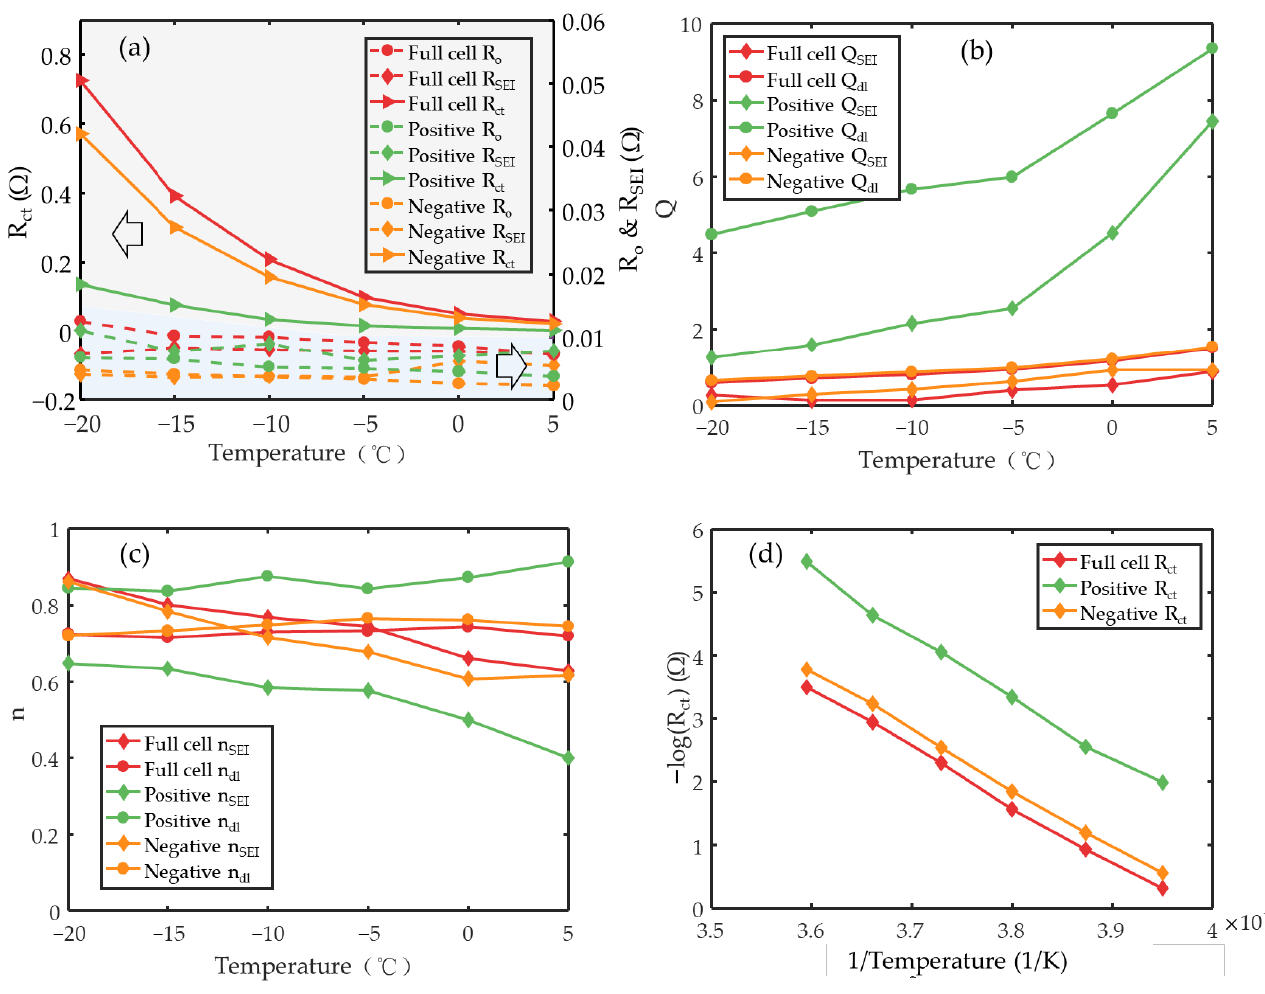
Figure 4. EEC fitted parameters: ( a ) Resistances; ( b ) coefficient of CPE, Q ; ( c ) exponent of CPE, n ; ( d ) Arrhenius plot of R ct .